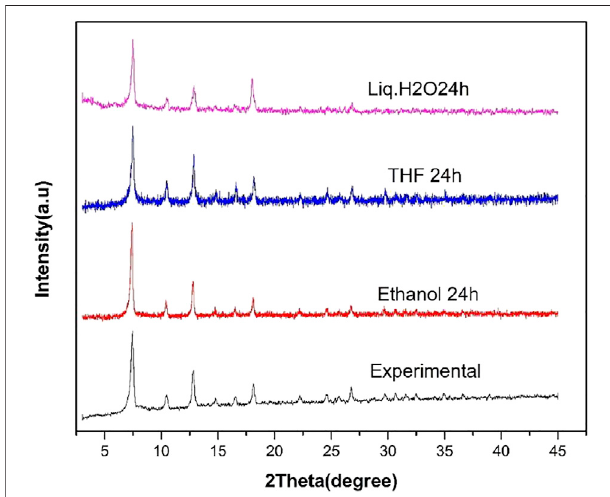
FIGURE 2 | TGA of ZIF-67.